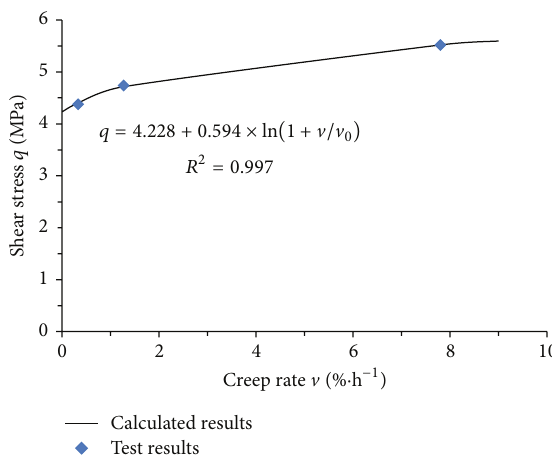
Figure 8: The long-term strength under the confining pressure of 0.3